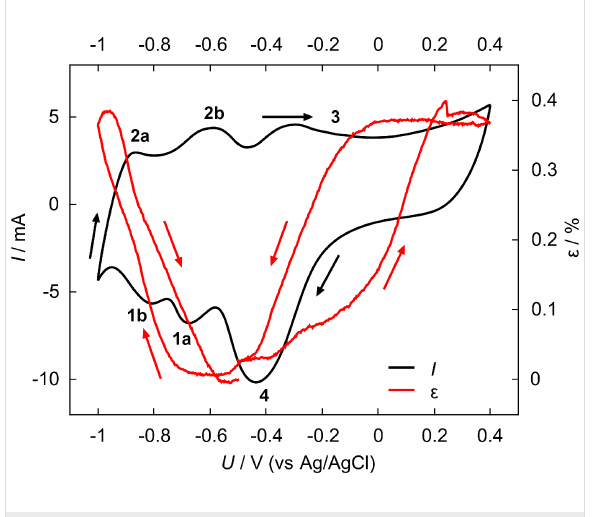
Figure 1: Current I (black) and corresponding strain ε (red) as func- tions of the applied potential U during a single voltammetric cycle for nanoporous palladium recorded at a scan rate of 0.5 mV·s − 1 in 1 M KOH, zero on the strain axis was chosen in the double-layer regime, arrows indicate the cycling direction of the curves, numbered peaks are discussed in the